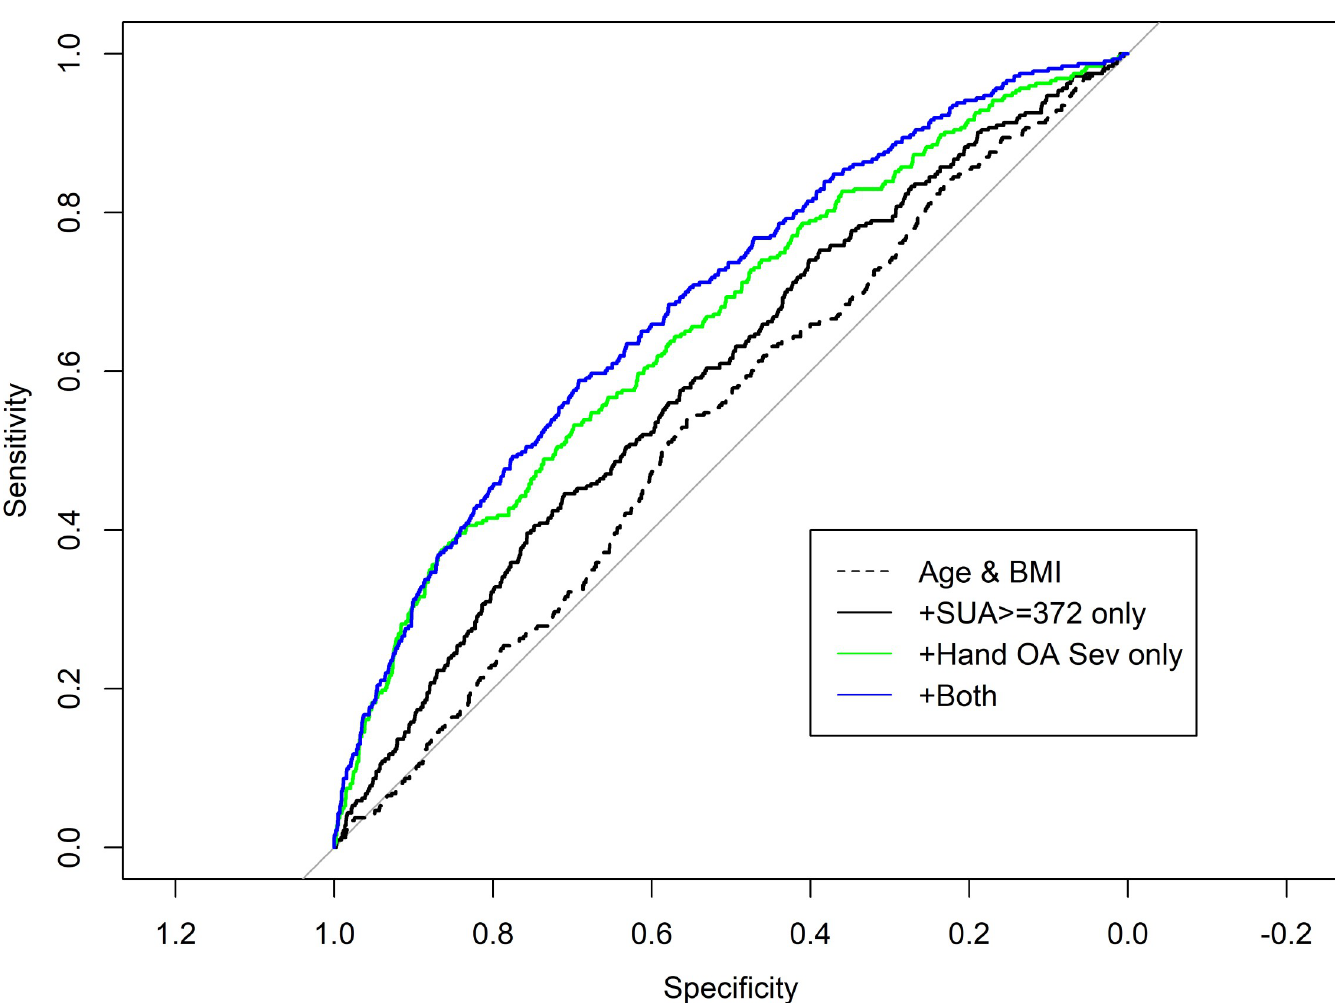
Fig 2. SUA levels and severe hand osteoarthritis as predictors of intermittent hand joint pain in � 10 hand joints. The figure shows the ROC curves for 4 different models. Model 0 with just age and BMI, model 1 adding only SUA � 372 μ mol/L as a threshold variable, model 2 adding only severe hand OA, and model 3 adding both variables. The area under the ROC curves were respectively: 0.58, 0.60, 0.66, 0.69. The difference in area under the curve between model 2 and model 3 was statistically significant p = 0.005. In other words, adding SUA � 372 μ mol/L as a threshold variable to a model with age, BMI, and severe hand OA significantly improves the capacity of the model to diagnose